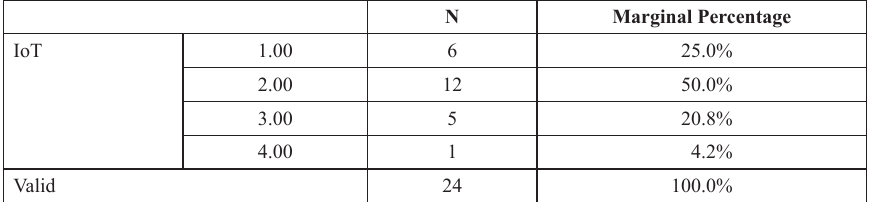
Table 5. The repetitions of the questionnaires and case